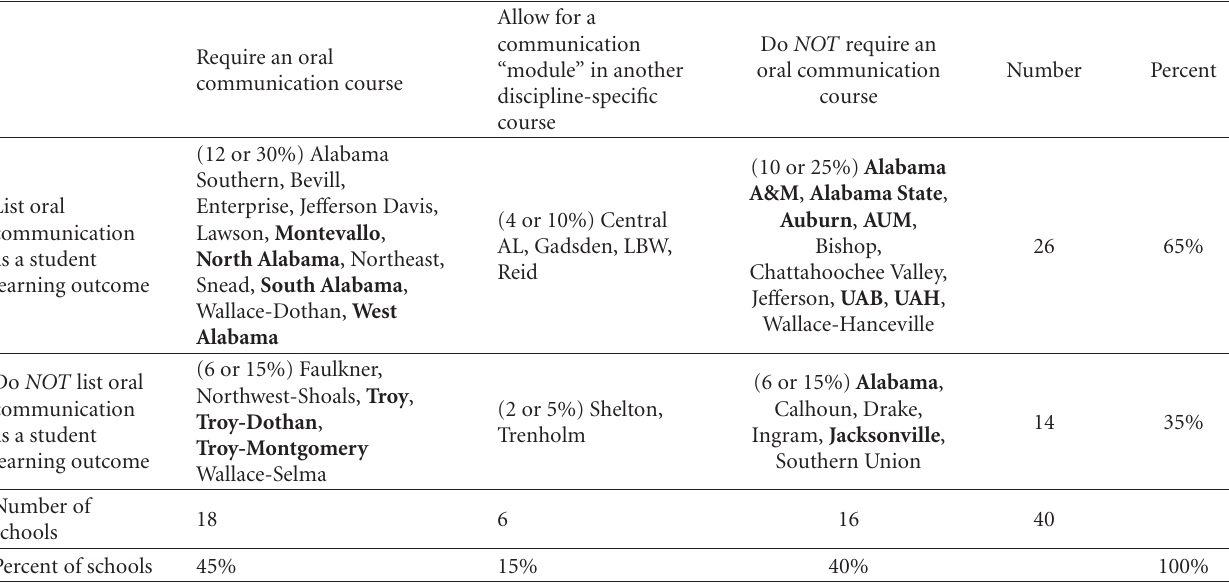
Table 2: Comparison of oral communication as a student learning outcome versus oral communication requirements in the general education